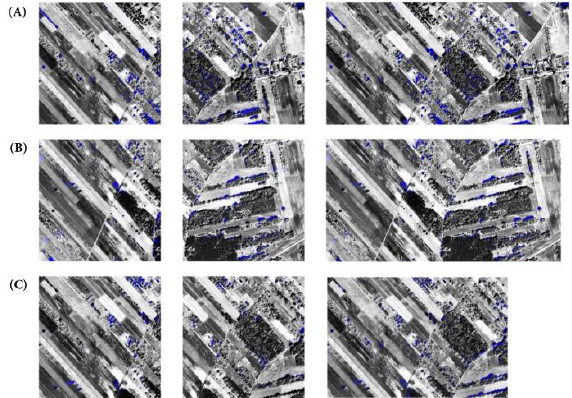
Figure 12. An example of the application of window function to combine shadow masks that were detected with the use of the UNet network. The images shown have an overlap of: ( a ) 5%, ( b ) 10%, ( c ) 50%. For panchromatic images (where histogram equalization was applied) window functions were not used.